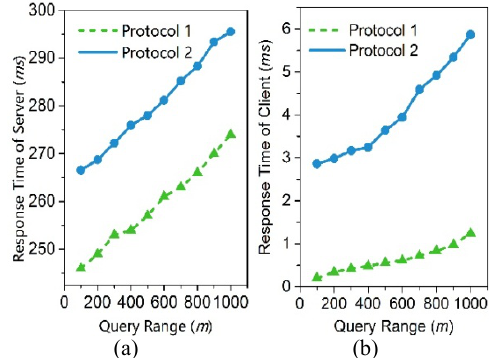
Fig. 5. The server- and client-side response time, variable